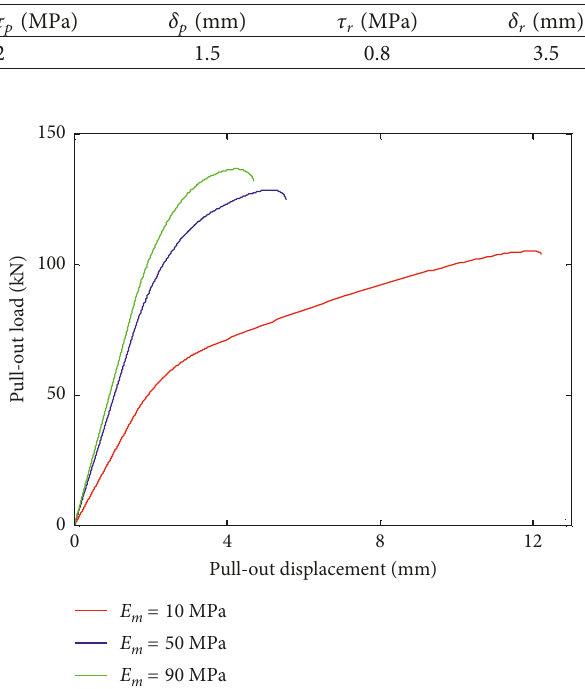
Table 6: Input parameters for the bond-slip model.